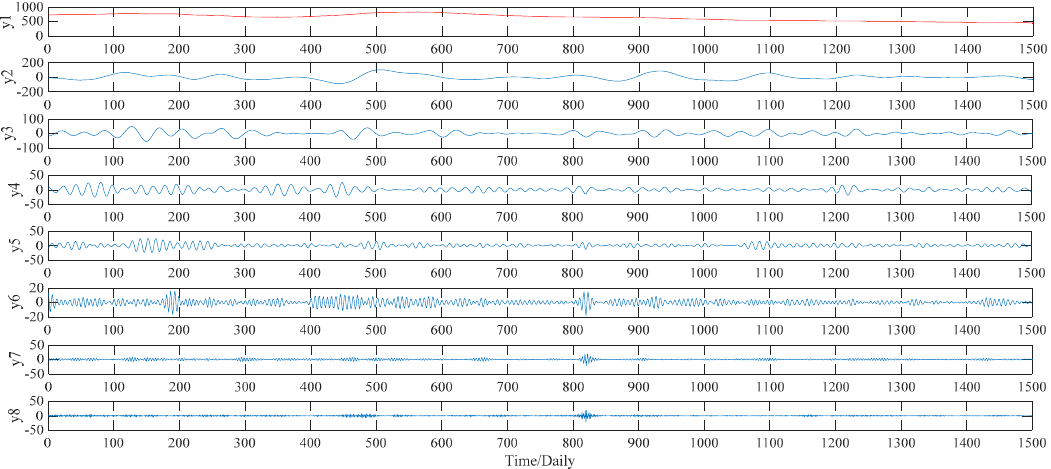
Figure 10. Decomposition results of the variational mode decomposition (VMD) method (wheat).